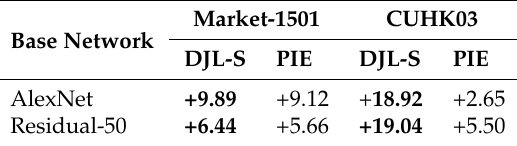
Table 3. Rank-1 accuracy improvement (%) over base networks compared with the PIE